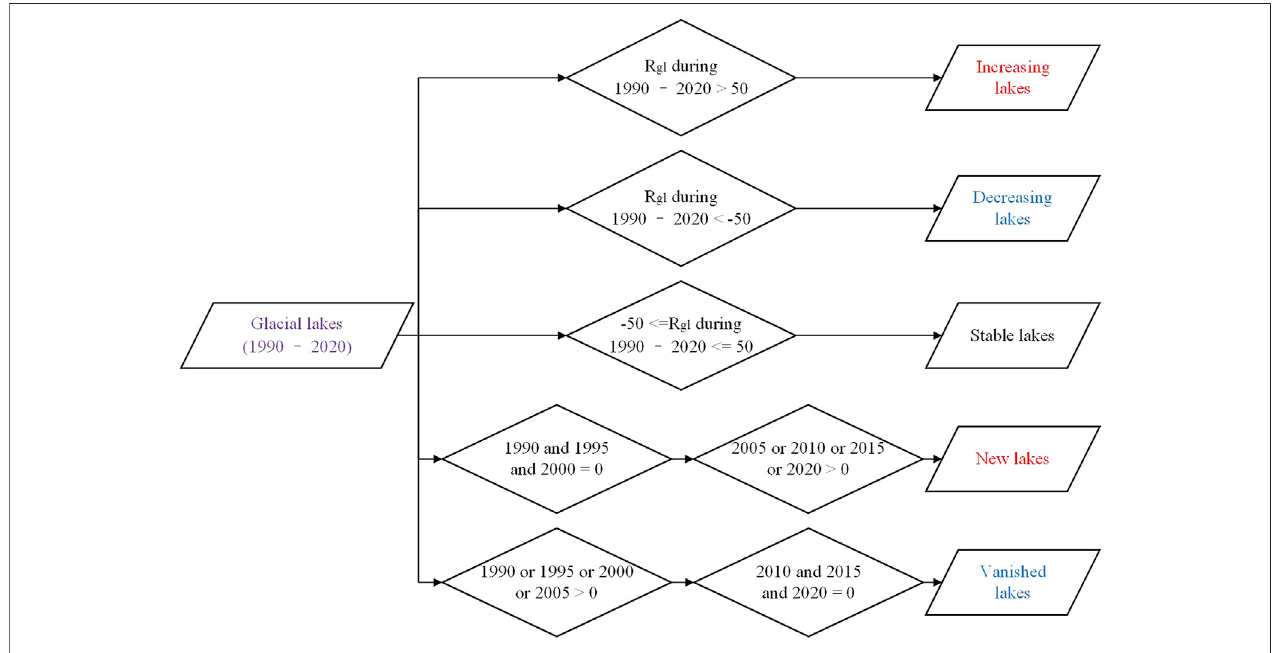
FIGURE 4 | Criteria for categorizing glacial lakes as increasing, decreasing, stable, newly appeared, and vanished. The units in the fi gure are m 2 · a − 1 .